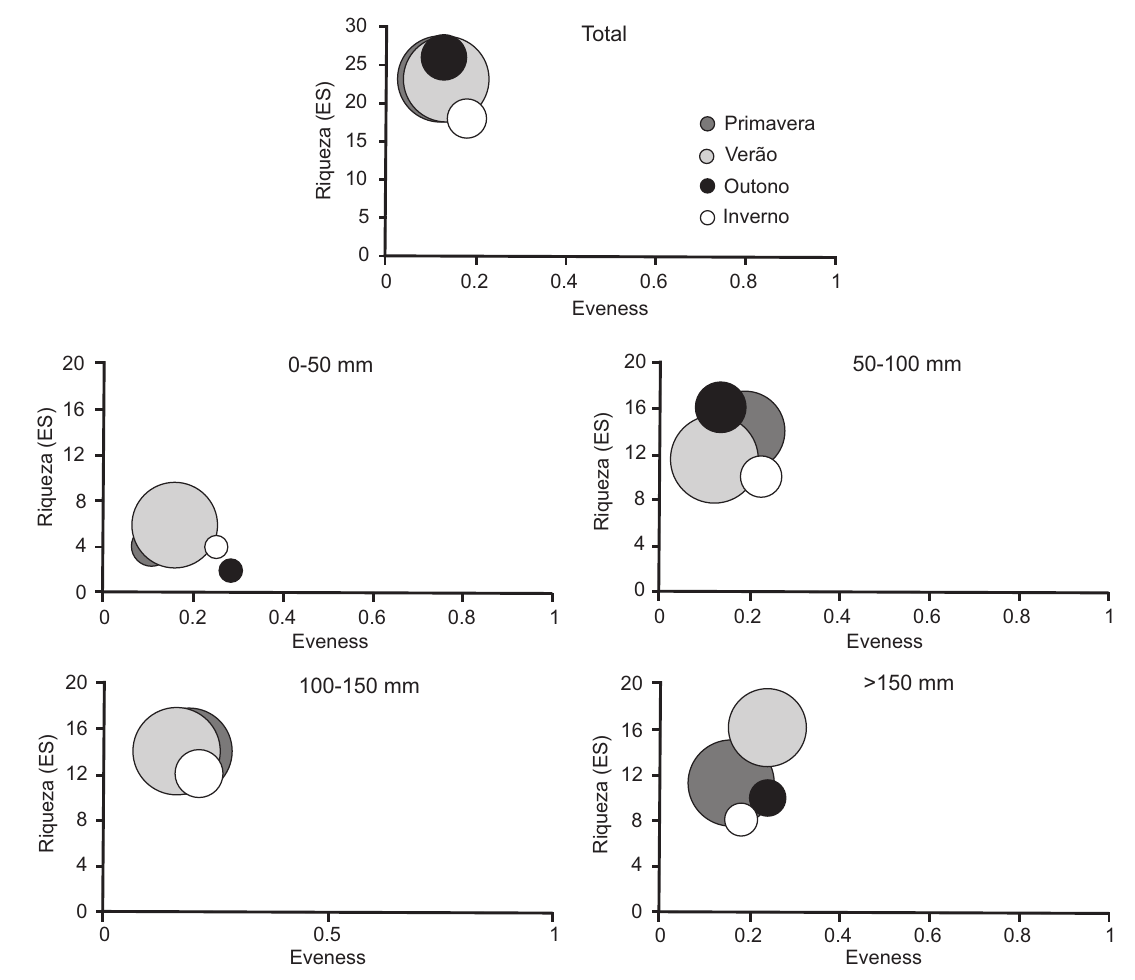
Figura 9. Diversidade geral da ictiofauna e por classe de comprimento. Riqueza de espécies (E(S)) no eixo y e equitatividade (Evar) no eixo x, o tamanho dos círculos são proporcionais aos valores da CPUAn para cada estação do ano: (P) primavera, (V) verão, (O) outono e (I)